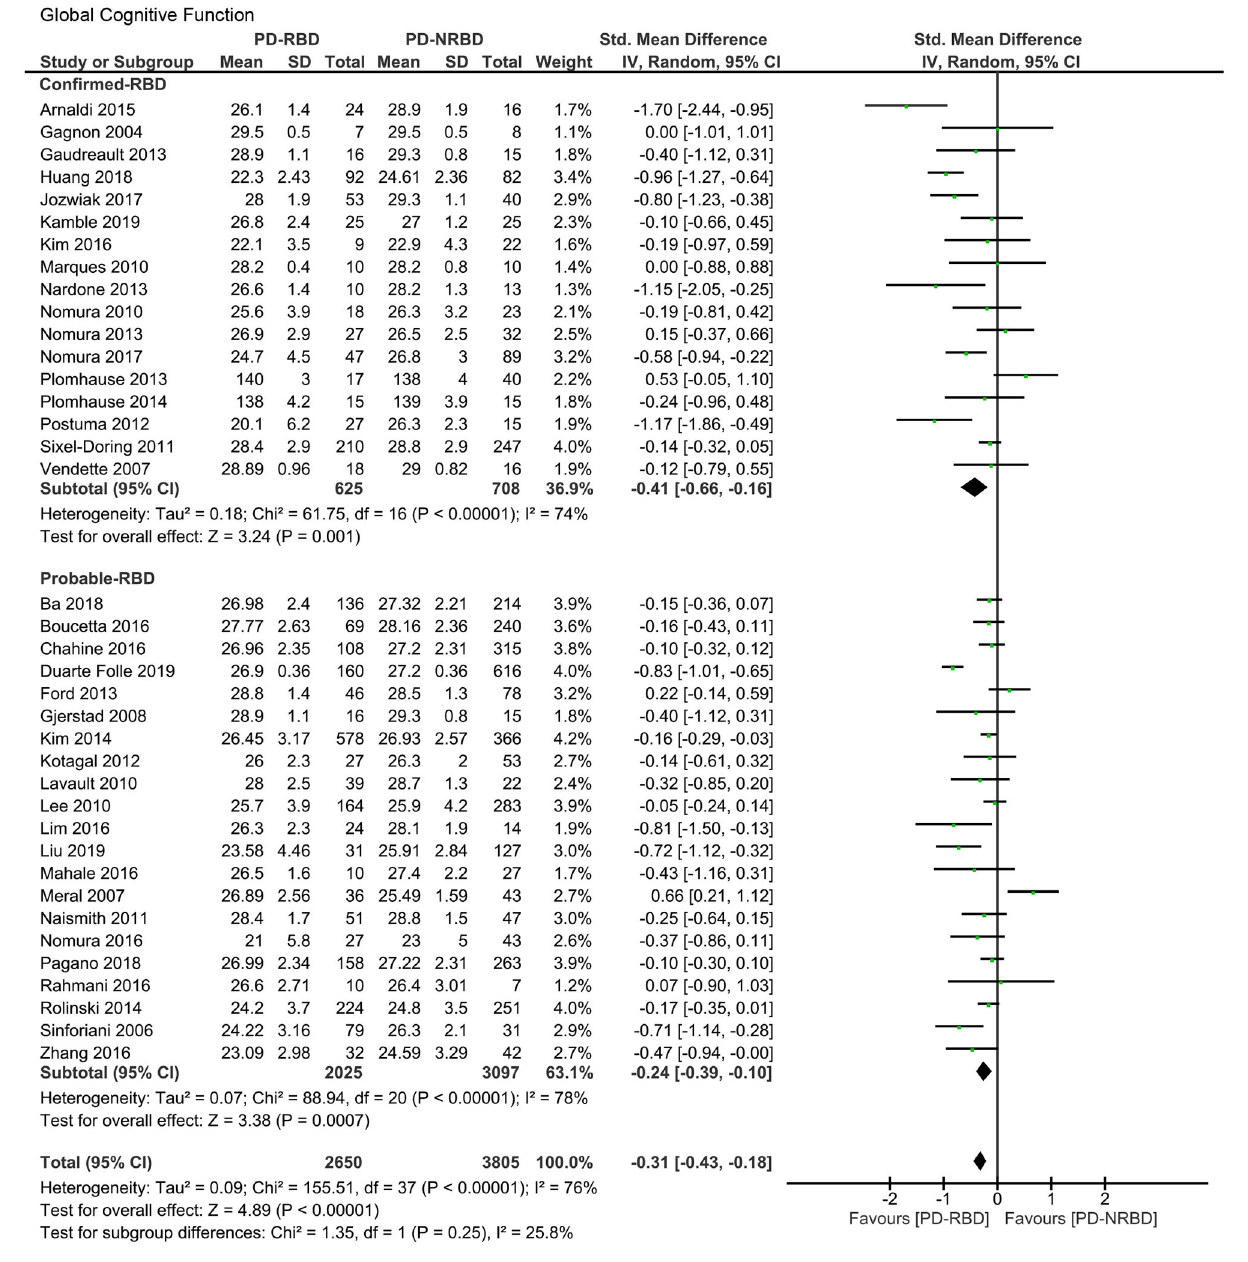
patients, with a medium ES (SMD = − 0.65, 95% CI = − 1.04 to − 0.26, P = 0.001); heterogeneity was absent ( I 2 = 19%) ( Table 3 , Figure 3E